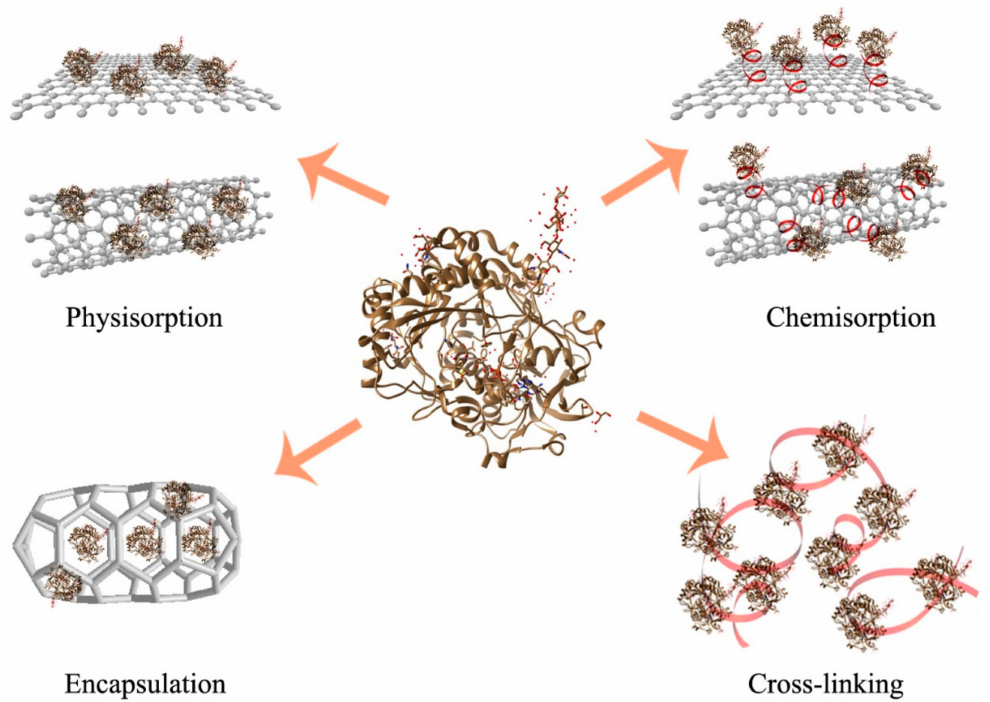
Figure 2. Schematic of different enzyme immobilization techniques. The crystal structure of Glucose Oxidase (GOx) isolated from Aspergillus Niger was used as a model enzyme (PDB ID: 3QVP)